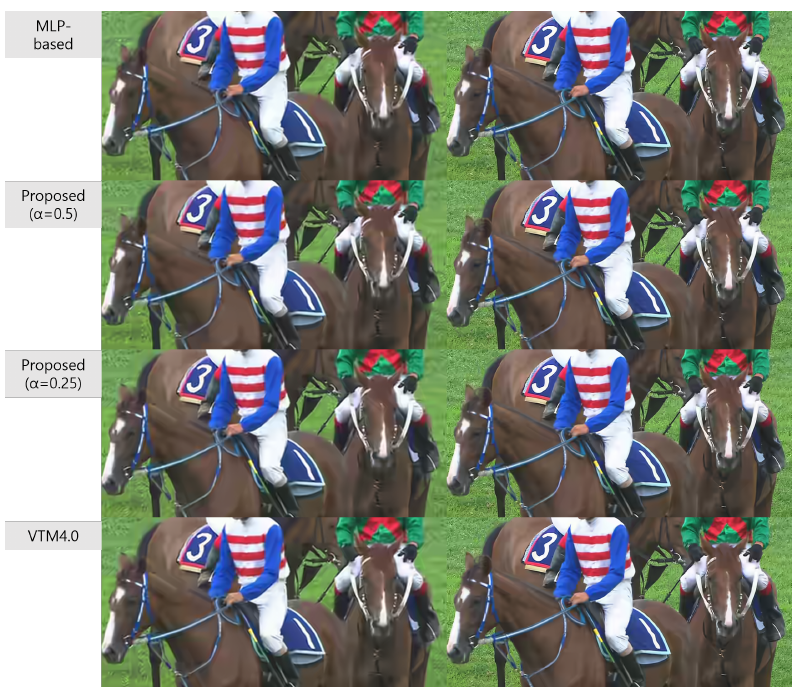
Figure 7. Decoded frames from RaceHorses (832 × 480) and RaceHorses (416 × 240) videos yielding the best ∆ EncT results presented in Table 8 when QP = 37.